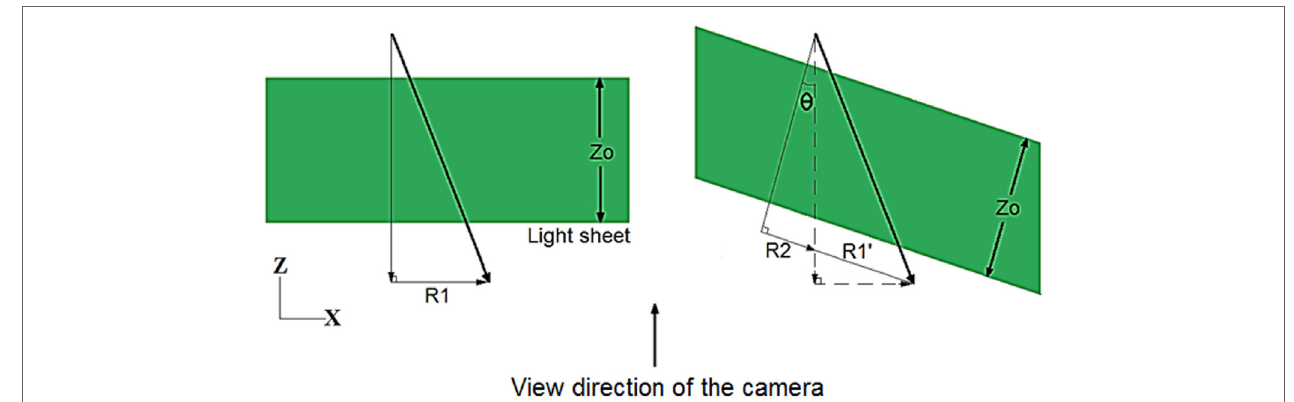
FigUre 7 | 3-D effect on measuring a vortex flow by PiV .